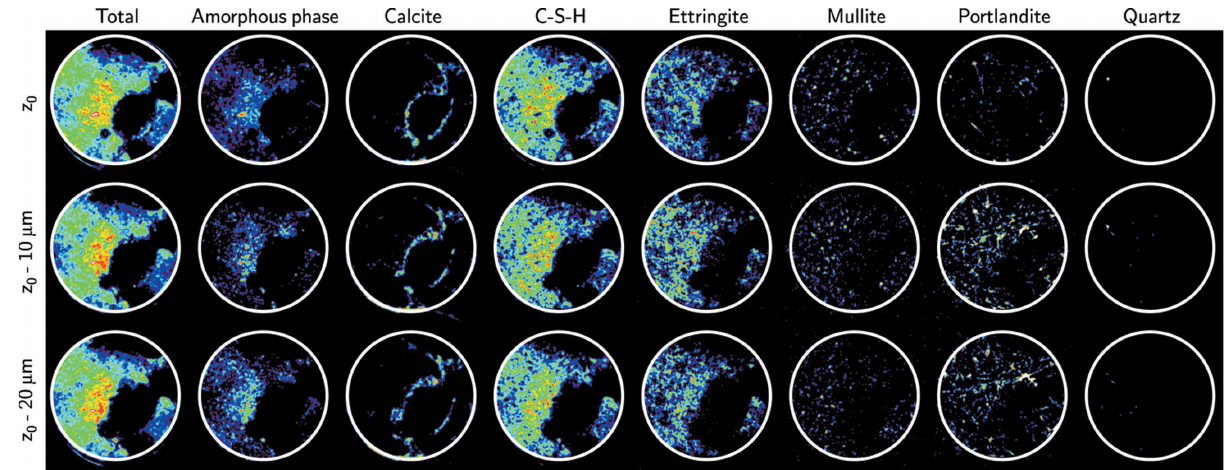
Figure 4 Distribution of the phases in the sample cured for six months. From left to right, the distribution maps integrate the contribution of all the identified phases, the amorphous phase, calcite, the C-S-H plus the calcite and the amorphous phase, and the ettringite, mullite, portlandite and quartz phases. Red values indicate a higher content of the phase in the distribution map. Black values indicate voids (Total map) and voids or absence of phase (all other maps). The typical ratio of counts for black values to red values is 0.2. Because all the maps were constructed from the number of counts integrated according to the procedure described in the Materials and methods section, they were scaled individually, and the sum of the colours for each map for the individual phases does not equal the colour of the total intensity map. The three slices were collected, from top to bottom, at vertical positions z 0 (arbitrarily chosen in the sample), 10 m m below z 0 and 20 m m below z 0 . As the beam size was 10 m m, the slices collected at z 0 and z 0 (cid:6) 10 m m are thus adjacent in the sample, as are those collected at z 0 (cid:6) 10 m m and z 0 (cid:6) 20 m m. The white circle of 1.6 mm diameter corresponds to the limit of the